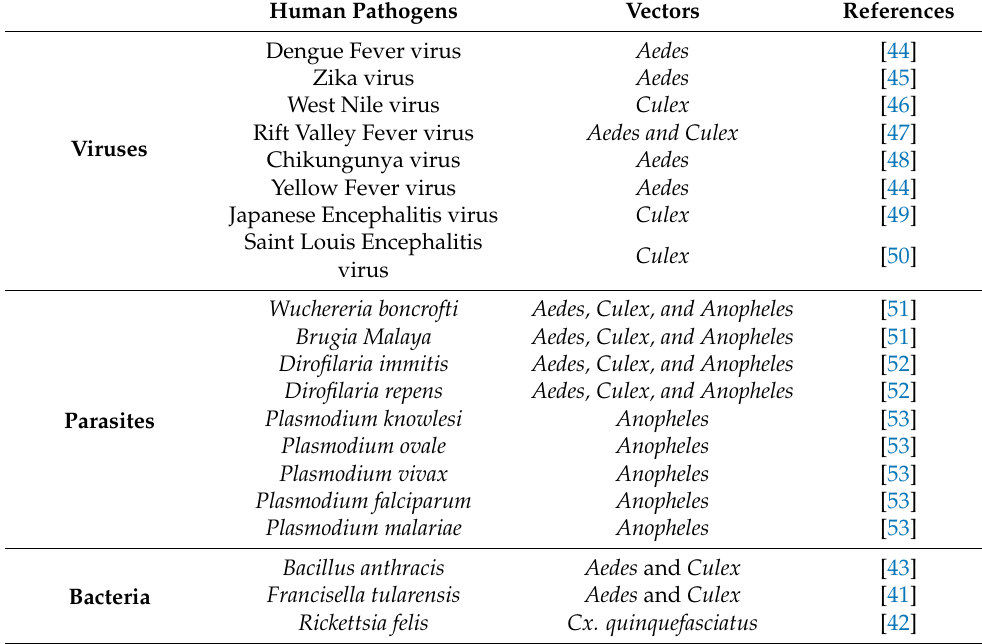
Table 1. Major mosquito-borne